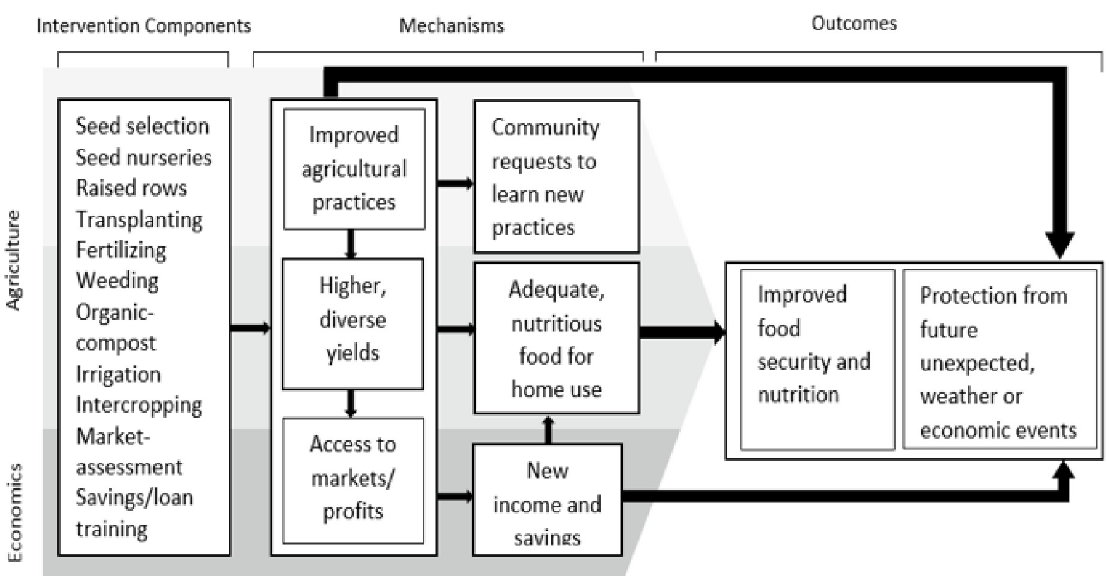
Fig 1. Conceptual framework of mechanisms between a multisector agricultural intervention and improved food security, nutrition, and protection from future shocks.